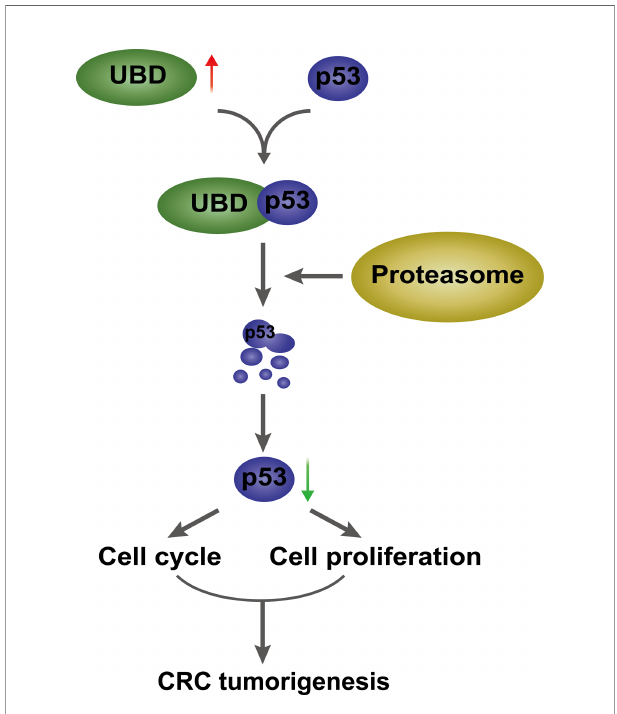
FIGURE 8 | A proposed model of UBD/p53 promoting CRC cell proliferation and tumorigenesis. UBD is upregulated in CRC, and may interact with p53 and facilitate p53 degradation through the proteasome pathway, which further promotes cell proliferation and cell cycle progression, ultimately, promotes CRC